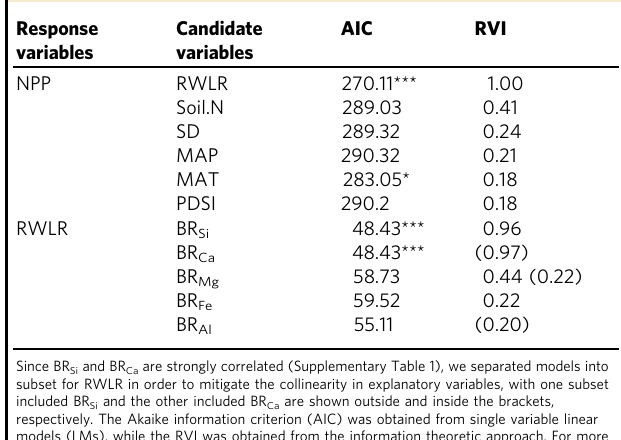
Table 2 Relative variable importance (RVI) of each candidate variable when predicting net primary productivity (NPP) and the regolith water loss rate